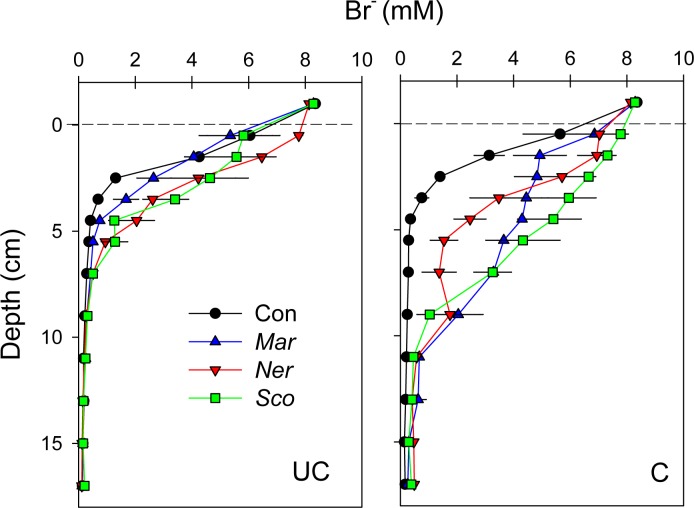
Depth profiles of Br- in uncultivated (UC) and cultivated (C) soils (upper and lower graphs, respectively) without (Con) or with polychaetes added (Mar: Marenzelleria viridis, Ner: Nereis diversicolor and Sco: Scoloplos armiger).Dashed lines indicate the sediment-water interface. Error bars indicate standard error (n = 3).